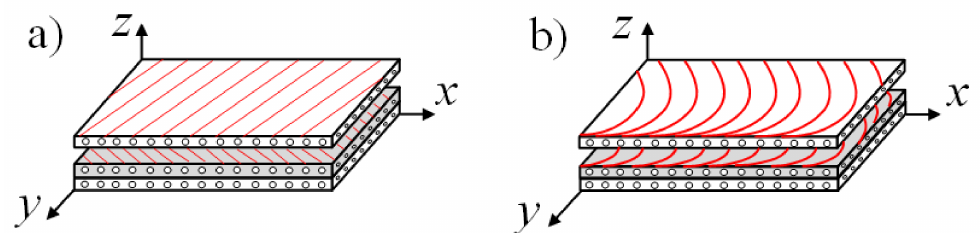
Figure 1. The section of composite material laminate: ( a ) CS and ( b ) VS